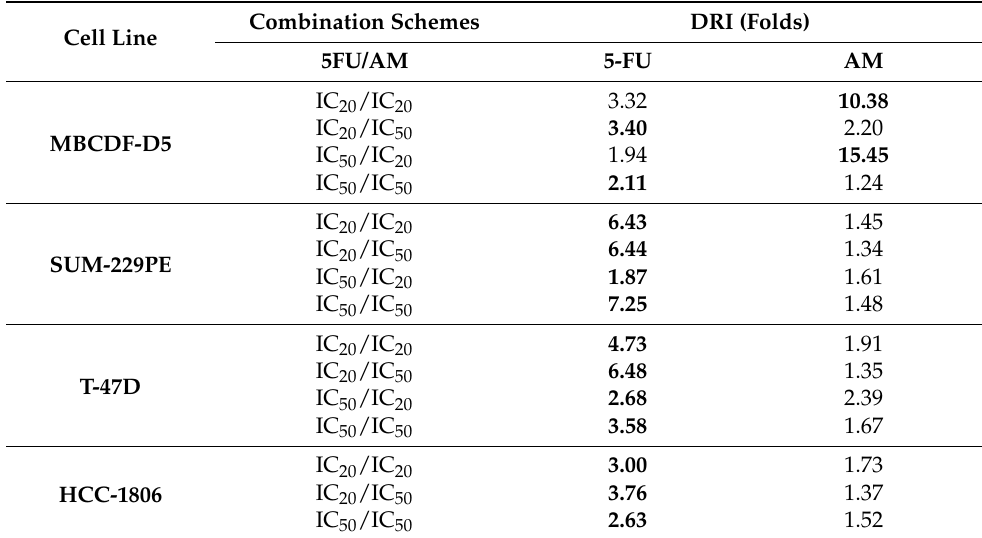
Table 3. Dose reduction index of 5 ‐ fluorouracil and α‐ mangostin.